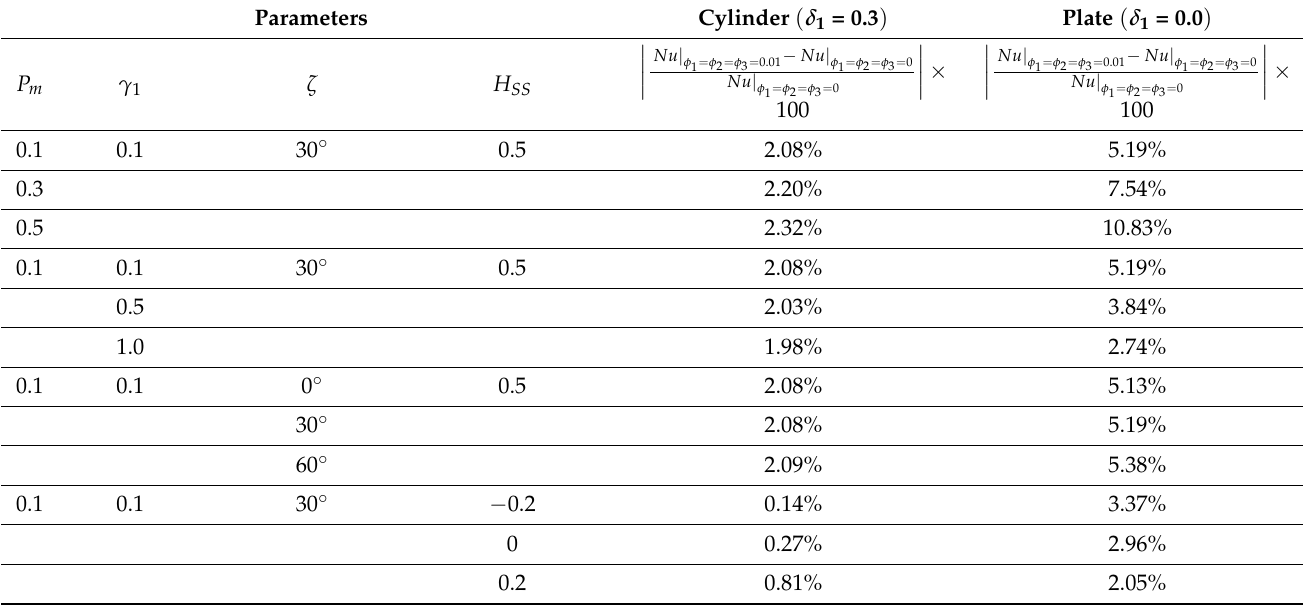
Table 3. Computational values of Nu % for various dimensionless